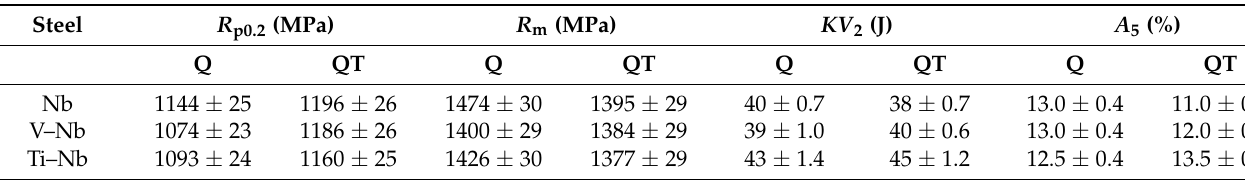
Table 3. Yield strength ( R p0.2 ), tensile strength ( R m ), impact toughness at − 40 ◦ C ( KV 2 ) and elongation ( A 5 ) for steel Nb, V–Nb, and Ti–Nb in Q and QT condition.